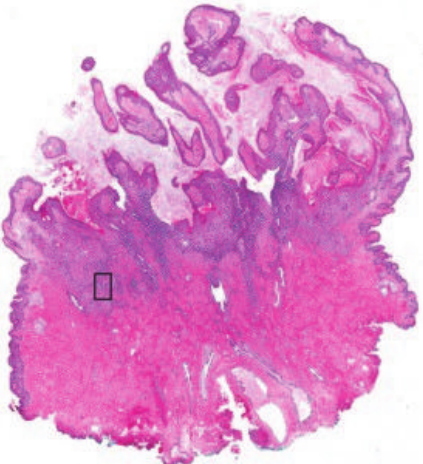
Figure 3: Whole slide image of the squamous cell carcinoma showing the keratoacanthoma-like features (HE). The box indicates the area shown in Figure